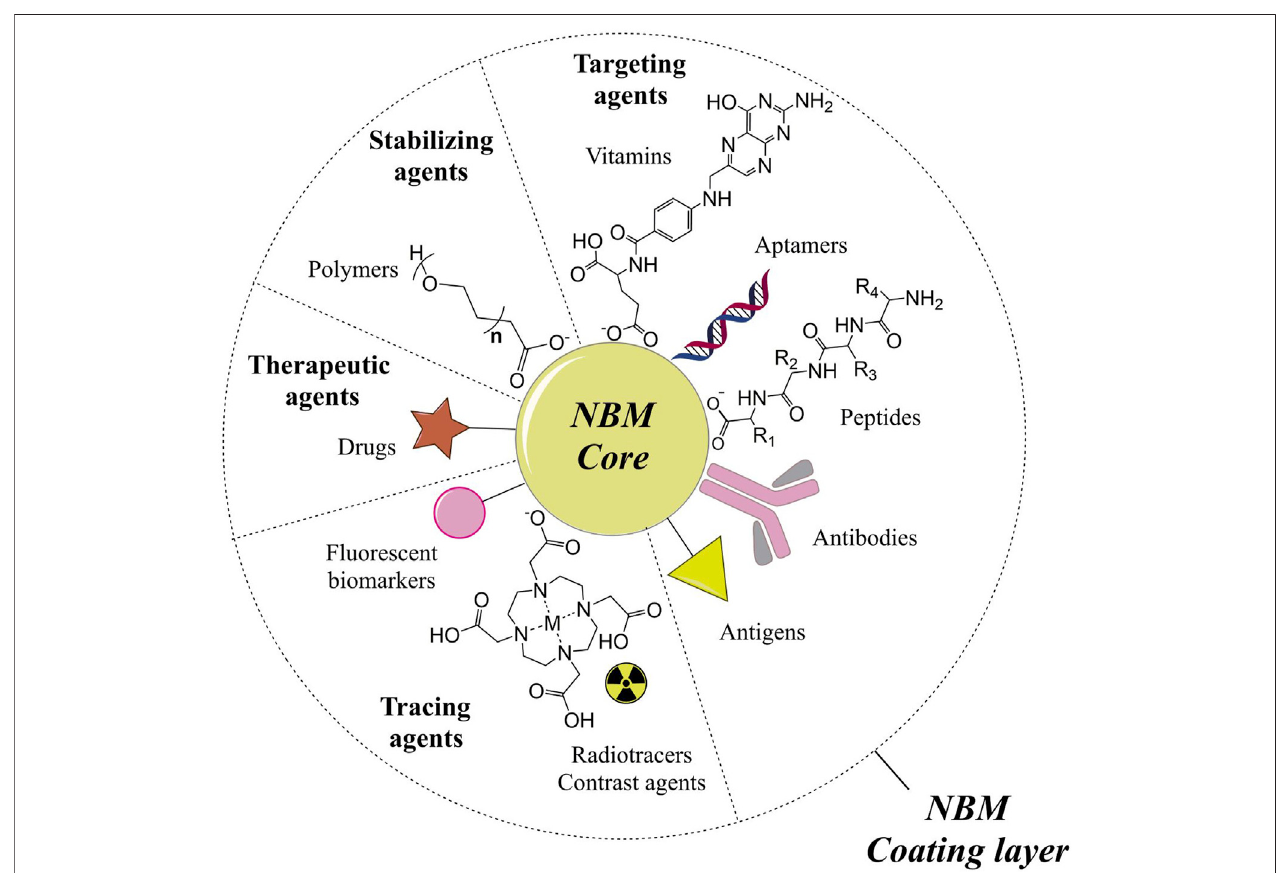
FIGURE 1 | Scheme illustrating the possible components of multifunctional nanobiomaterials (NBMs). The NBM core can be made of materials such as metals, metaloxides,polymers,lipids,amongothers,butthisreviewisfocusedonNBMsbasedonNBMswithIOandTiO 2 coresconjugatedtodifferentmolecules(coatinglayer orshell).Thesemoleculesareclassi fi edaccordingtothefunctionalitytheyadduptotheNBM:therapeuticagents( e.g. drugs);stabilizingagents( e.g. polymers);targeting agents suchas vitamins, aptamers, peptides, antibodies, andantigens;and tracingagentssuchas fl uorescent biomarkers, radiotracers, andcontrastagents.The diameter of the core and the thickness of the molecular coating layer are not been shown in the actual proportion in the scheme, as they may vary according to each engineered